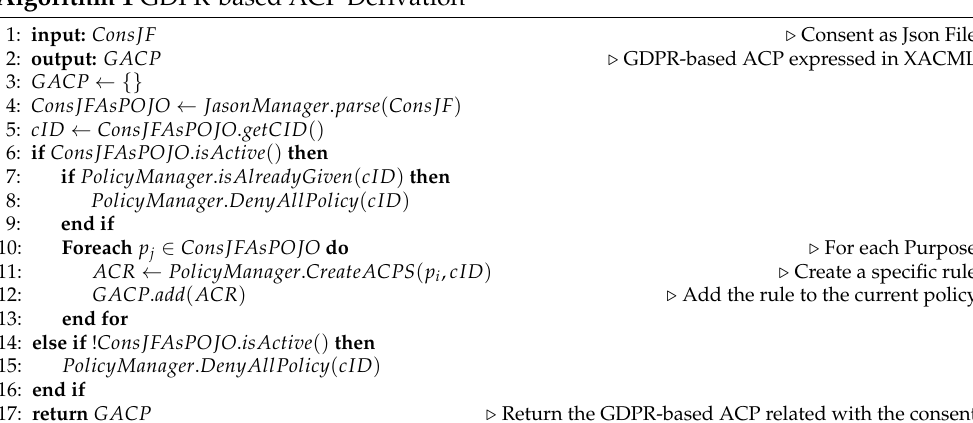
Algorithm 1 GDPR-based ACP